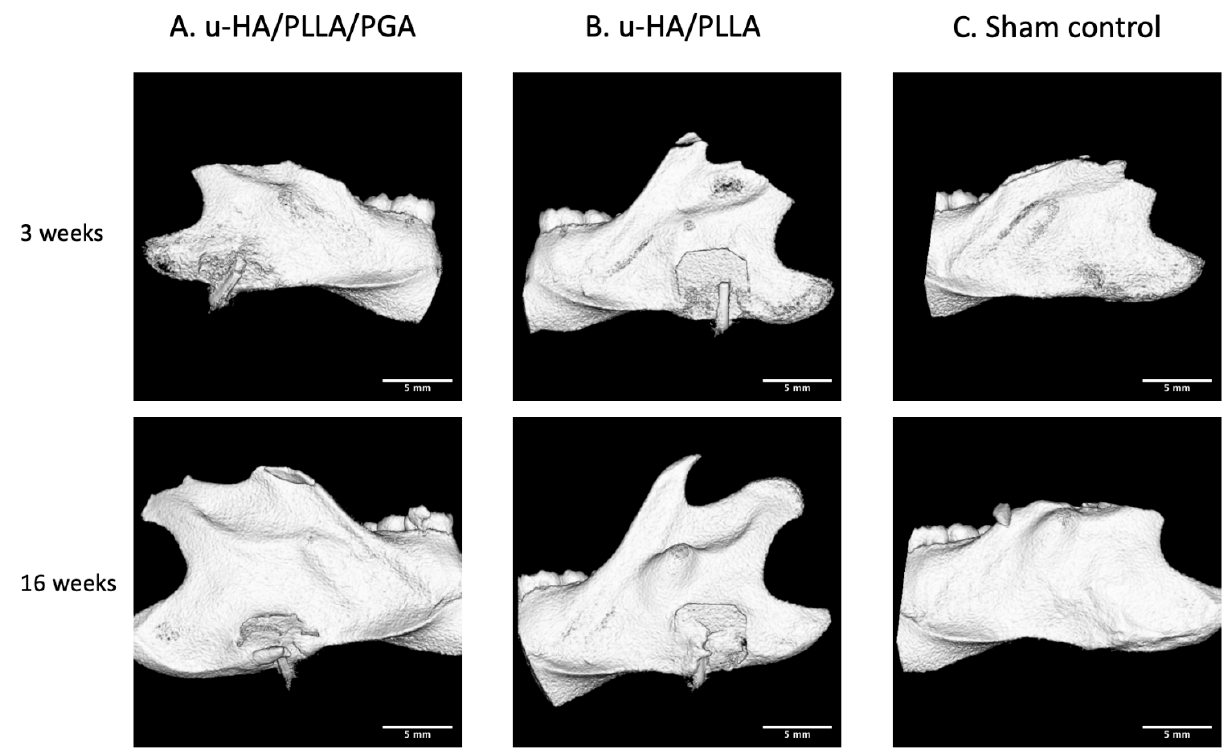
Figure 5. Micro-CT images of rat hemi-mandibles. The u-HA/PLLA/PGA is not visible due to the low proportion of u-HA. 3D view of the ( A ) u-HA/PLLA/PGA subgroup, ( B ) u-HA/PLLA subgroup, and ( C ) sham control group. Scale bar: 5 mm.